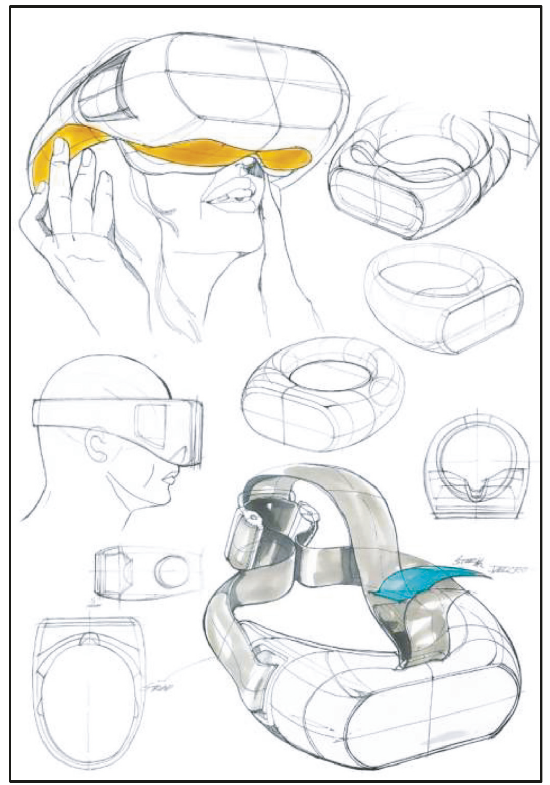
Figure 3: A concept sketch of virtual reality (VR) goggles [28].